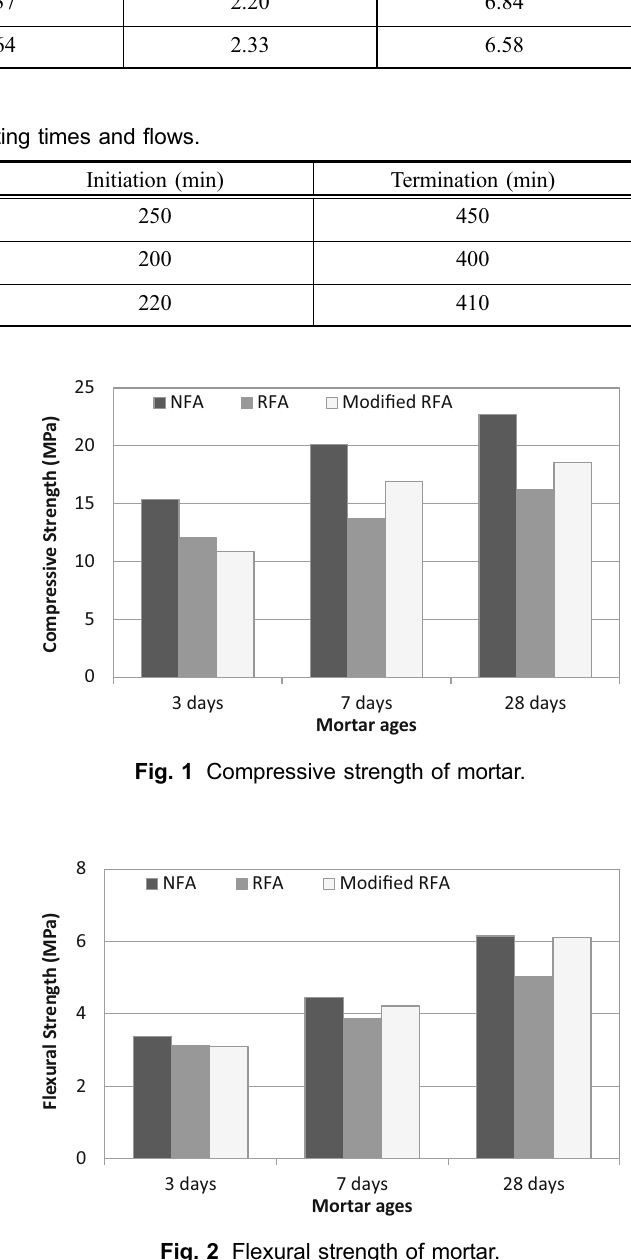
Fig. 2 Flexural strength of mortar.